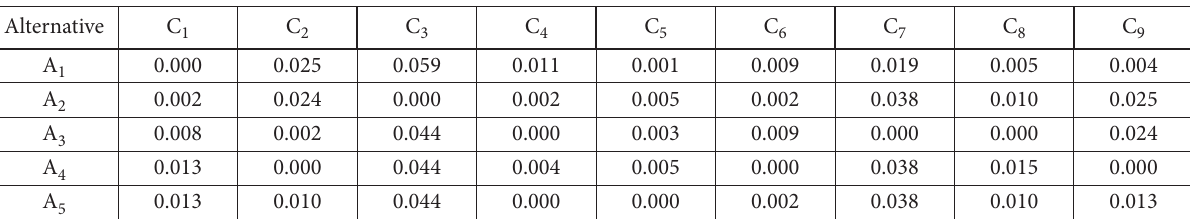
Table 9. The real evaluation matrix for Scenario 1